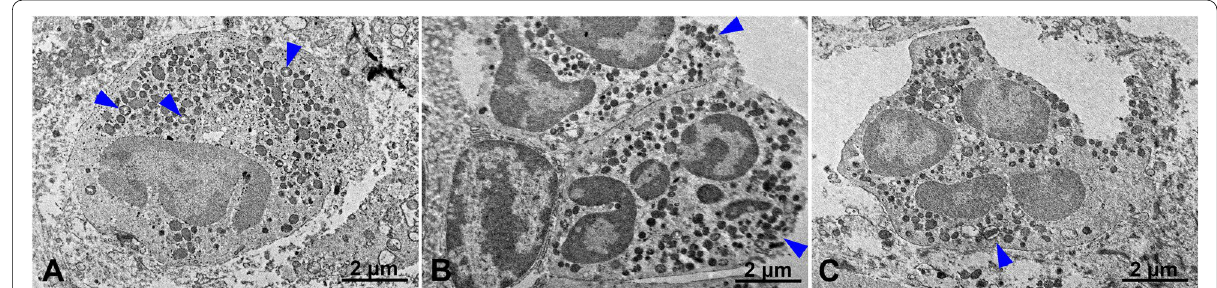
Fig. 6 The presence of immune cells was recorded in TEM images of peri-implant soft tissue retrieved from case 1. Images of neutrophils ( A ), macrophages ( B ), and eosinophils ( C ) with cytoplasm filled with exosomes were recorded ( A – C blue arrowheads). There is a sample image of metal particles in the cytoplasm of a macrophage ( A )